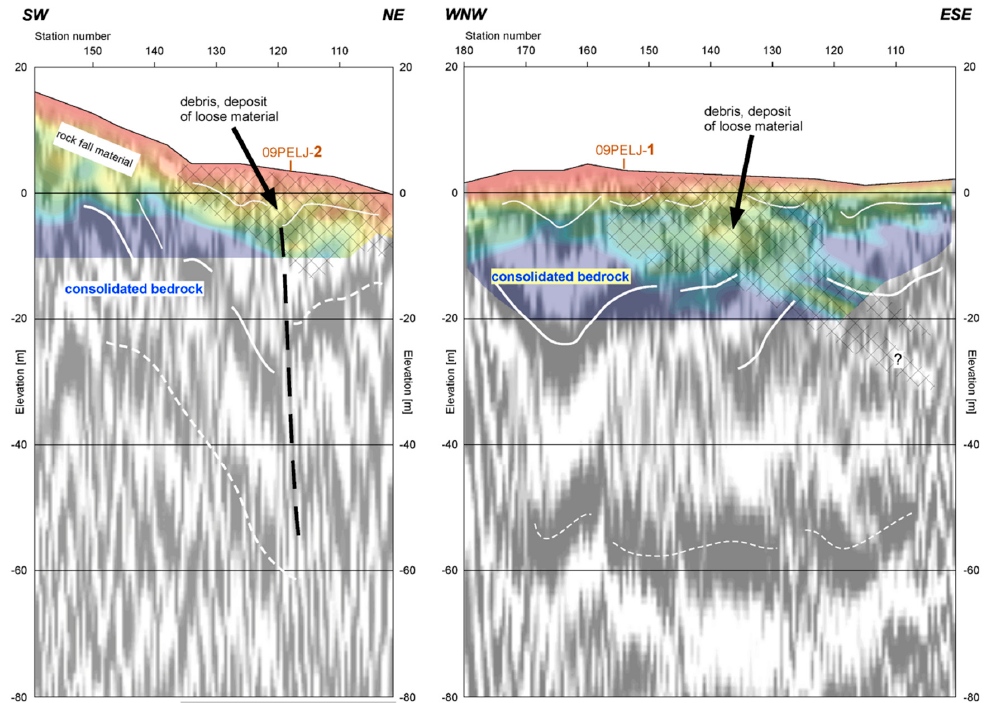
Figure 6. The hybrid seismic interpretation technique applied at the location of Peljesac bridge abutment, from [44]. abutment, from